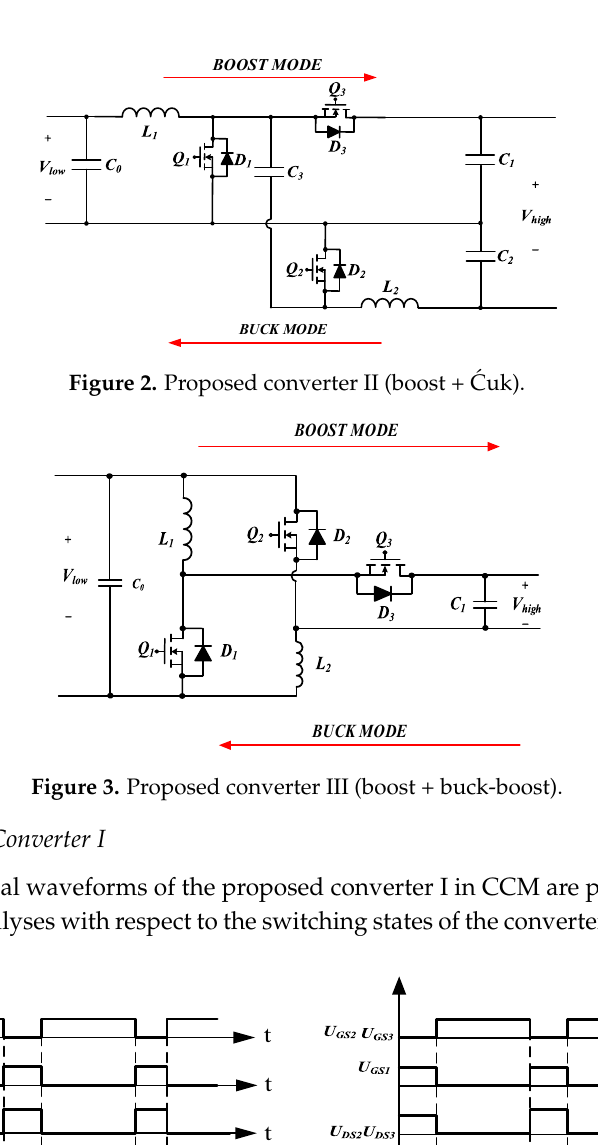
Figure 5. Topological states of the converter I in boost mode. ( a ) [ t 0 –t 1 ]. ( b ) [ t 1 –t 2 ].